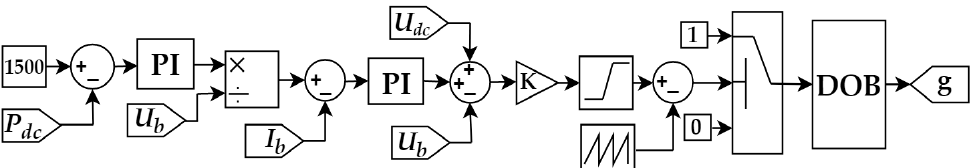
Figure 4. A control flow chart of the DC bus control algorithm. PI: proportion-integral; DOB: disturbance observer.